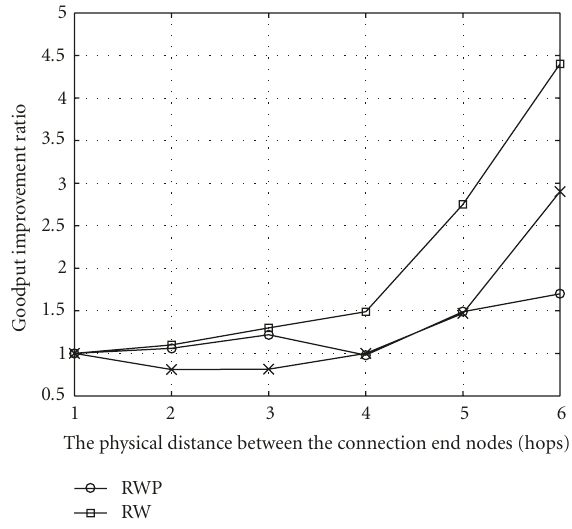
Figure 9: Goodput improvement ratio